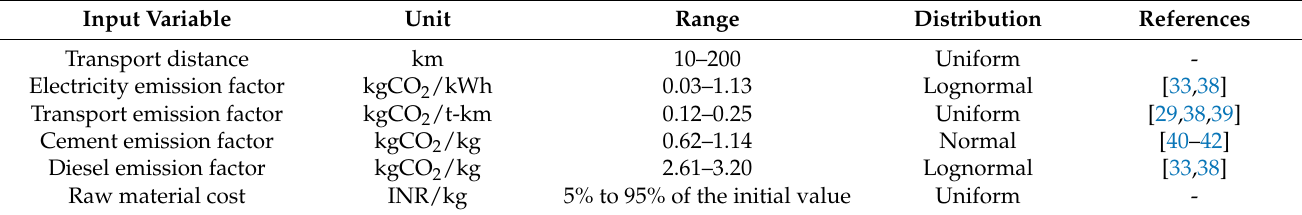
Table 5. Input variables and the variations used for sensitivity